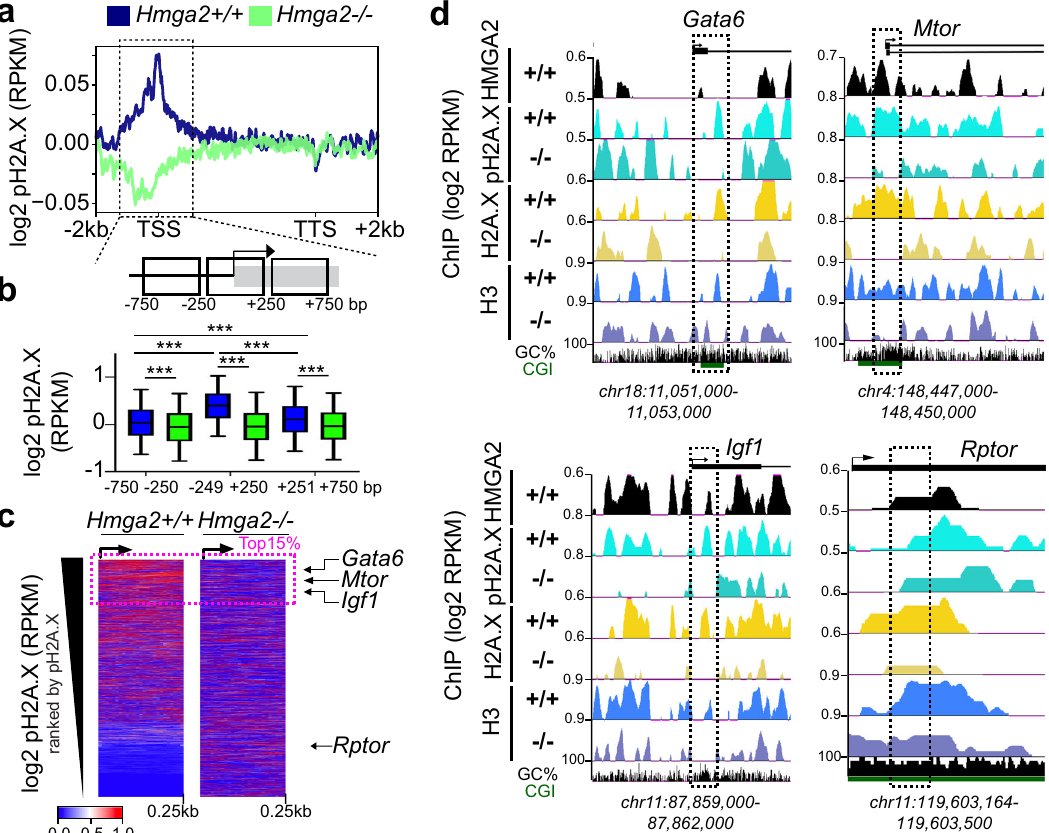
Fig. 1 HMGA2 is required for pH2A.X deposition at TSS. a Aggregate plot for pH2A.X enrichment within the gene body ±2 kb of UCSC Known Genes in Hmga2 + / + and Hmga2 − / − MEF. ChIP-seq reads were normalized using reads per kilobase per million (RPKM) measure and are represented as log2 enrichment over their corresponding inputs. TSS, transcription start site; TTS, transcription termination site. Dotted square, ±750 bp region around the TSS. b Top, schematic representation of the genomic region highlighted in a. Bottom, box plot of pH2A.X enrichment in the genomic regions showed as squares at the top in Hmga2 + / + and Hmga2 − / − MEF. RPKM of the pH2A.X ChIP-seq were binned within each of these genomic regions and represented as log2. Box plots indicate median (middle line), 25th, 75th percentile (box) and 5th and 95th percentile (whiskers); n = 9522 genes enriched with pH2A.X; asterisks P -values after two-tailed Wilcoxon – Mann – Whitney test, *** P ≤ 0.001. c Heat map for pH2A.X enrichment at the TSS + 0.25 kb of UCSC Known Genes in Hmga2 + / + and Hmga2 − / − MEF. Genes were ranked by pH2A.X enrichment in Hmga2 + / + MEF. Doted square, the top 15% ranked genes, as well as Gata6 , Mtor , Igf1 and Rptor were selected for further analysis. d Visualization of selected HMGA2 target genes using UCSC Genome Browser showing HMGA2 (black), pH2A.X (turquoise), H2A.X (yellow) and H3 (blue) enrichment in Hmga2 + / + and − / − MEF. ChIP-seq reads were normalized using RPKM measure and are represented as log2 enrichment over their corresponding inputs. Images show the indicated gene loci with their genomic coordinates. Arrows, direction of the genes; black boxes, exons; dotted squares, regions selected for single gene analysis. See also Supplementary Fig. 1. Source data are provided as a Source Data fi les 01